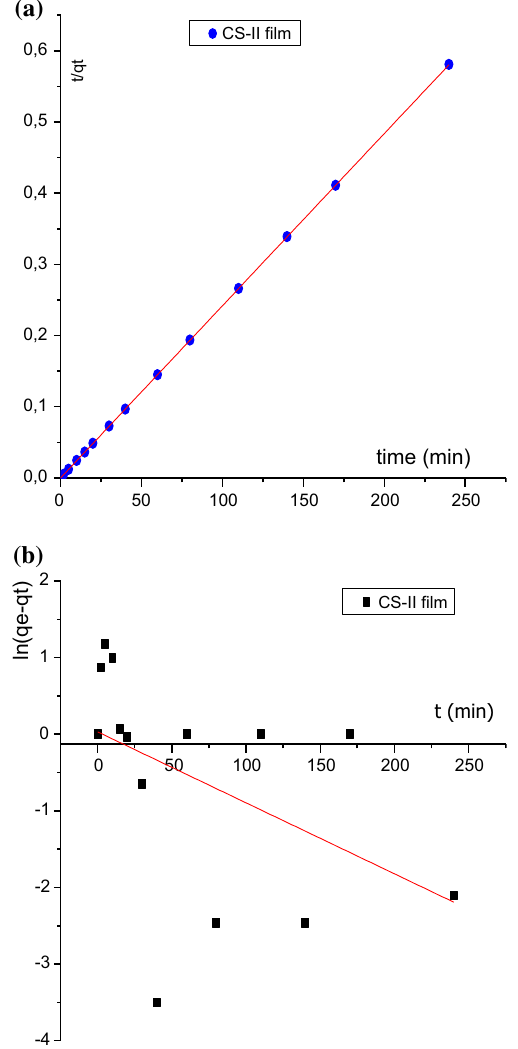
Fig. 6 Kinetic study of EBT adsorption on CS-II film a pseudo-sec- ond order, b pseudo-first order